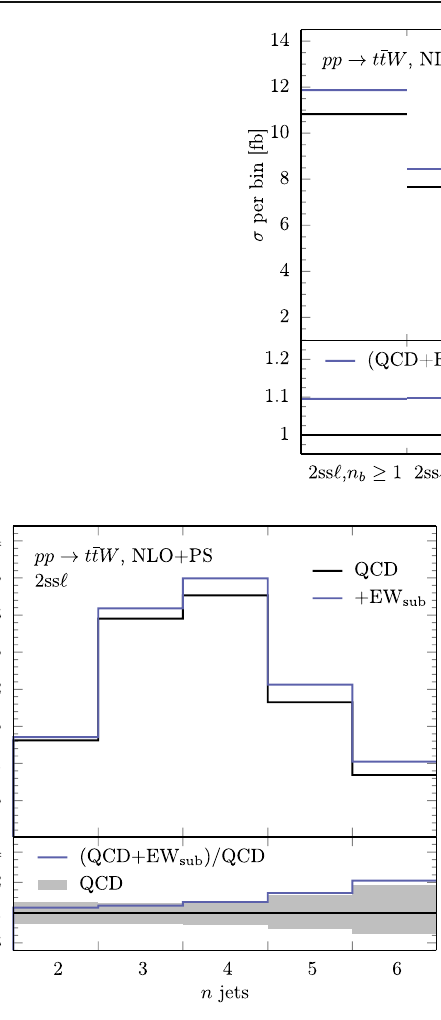
Fig. 6 Effect of the EW sub contributions on the cross section and the jet multiplicities for the 2ss (cid:7) and 3 (cid:7) signatures